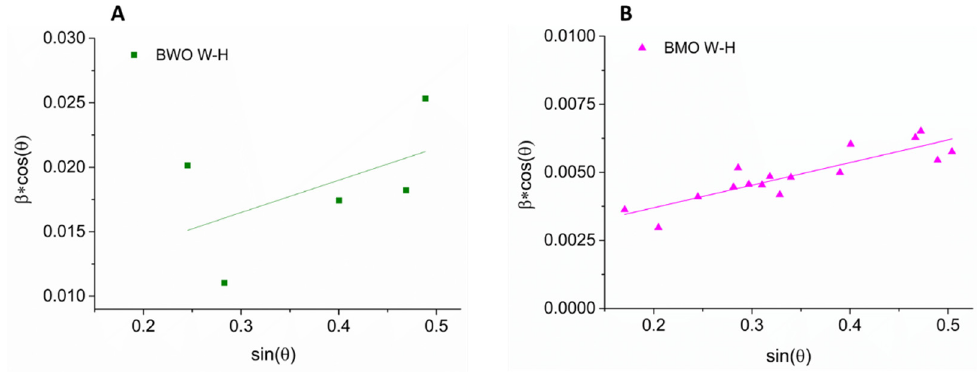
Figure 1. X-ray diffraction (XRD) of ( A ) BiOBr; ( B ) BWO and ( C ) BMO; transmission electron microscopy (TEM) images of ( D ) BiOBr, ( E ) BWO, and ( F ) BMO.